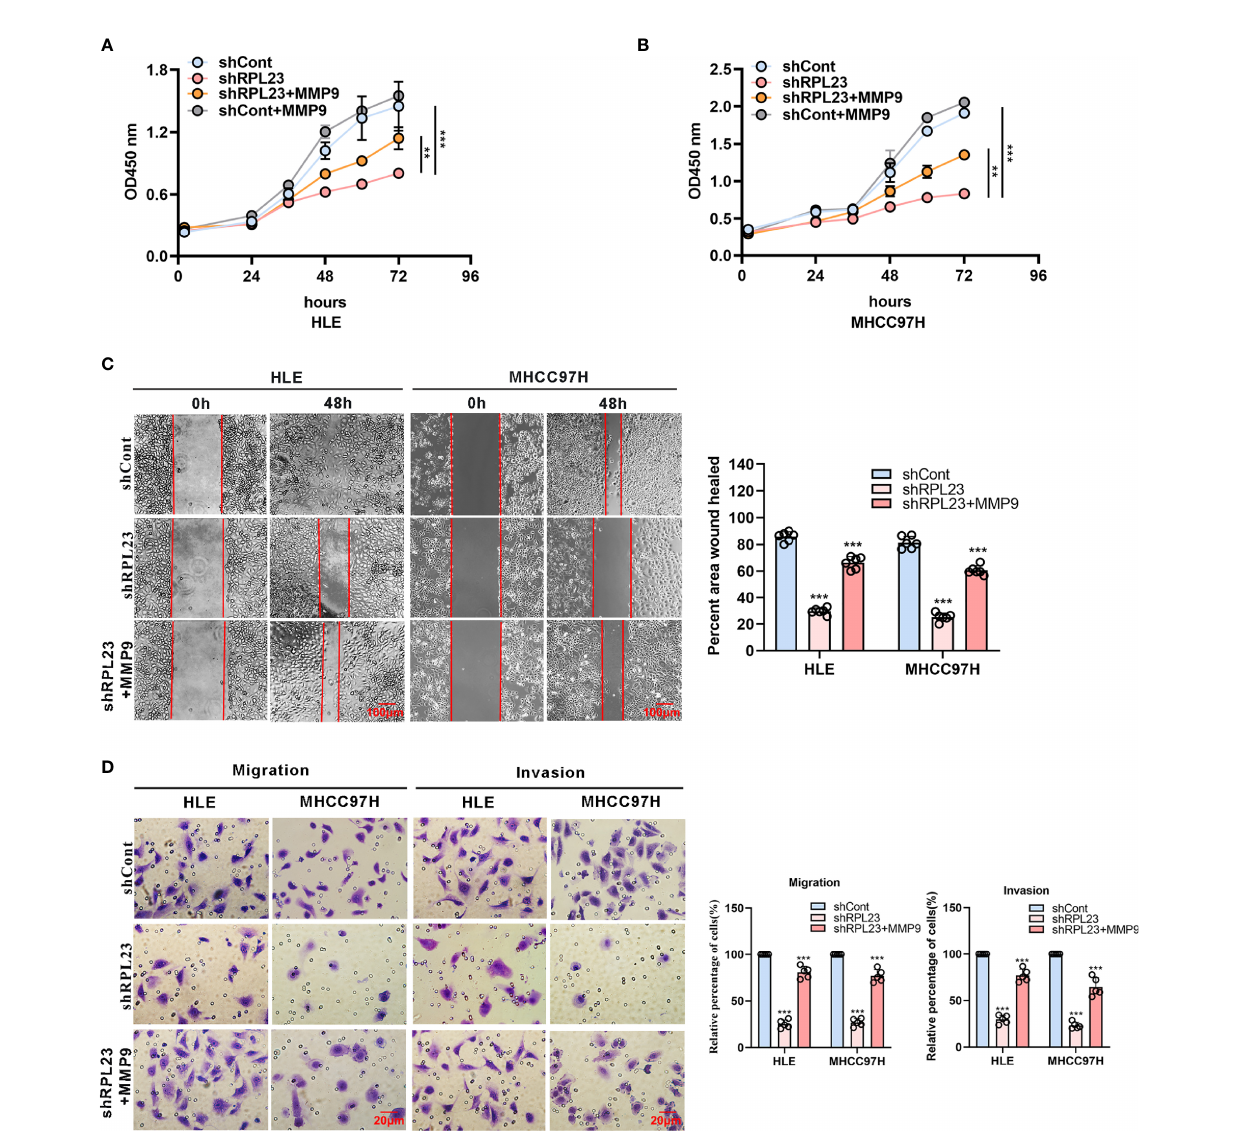
FIGURE 6 | MMP9 overexpression rescues the RPL23 knockdown-induced malignant phenotypes. (A, B) Overexpression of MMP9 rescued the inhibition effect of decreased RPL23 on HCC cell proliferation. (C) overexpression of MMP-9 rescued the repression effect of knockdown RPL23 on HCC cell migration ability by wound-healing assay. The cells were counted from 6 images. (D) Upregulation of MMP-9 could signi fi cantly rescued the effects of decreased RPL23 in HLE and MHCC97H cells for both migration and invasion by transwell assays. The cells were counted from 5 images. Representative data are from at least three independent experiments. Data are shown as mean ± SD. **P < 0.01, ***P <